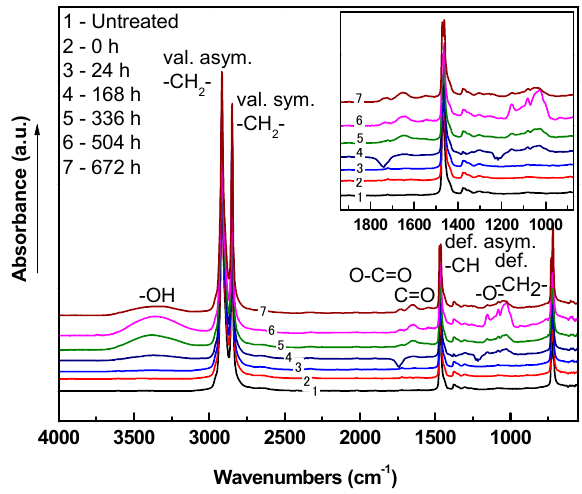
Figure 19. FTIR spectra of LDPE plasma treated for 120 s using argon and stored in water. Changes in a surface chemical composition of the LDPE surface before and after plasma treatment were evaluated using XPS. The chemical composition of elements existing on the treated surface was obtained from the C1s, O1s, and N1s peaks, as shown in Table 1. The quantification (at.%) equal to 97.41 at.% and 2.59 at.%, respectively. Although the LDPE structure does not contain